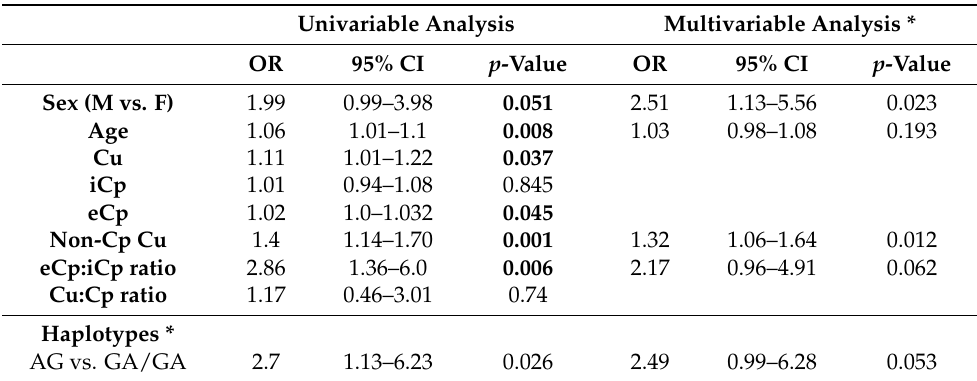
Table notes: Biochemical variables with a p- value < 0.10 at the univariable analysis (bold values in the table) were included in the multivariable analysis. Cu and eCp were not included to avoid the multicollinearity with Non-Cp Cu and eCp:iCp ratio, respectively. * The analysis was carried out on 160 individuals. OR, odds ratio; CI, confidential